Question: Name the type of graph shown.
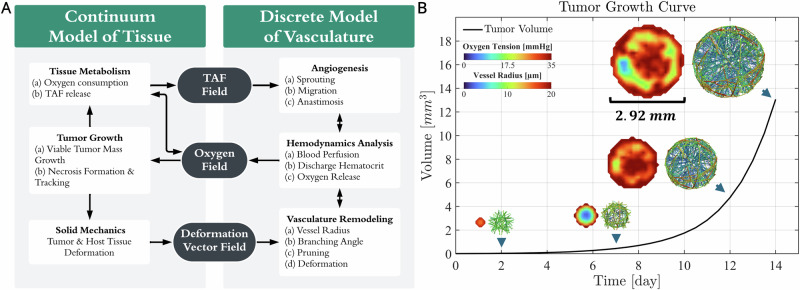
Answer: line